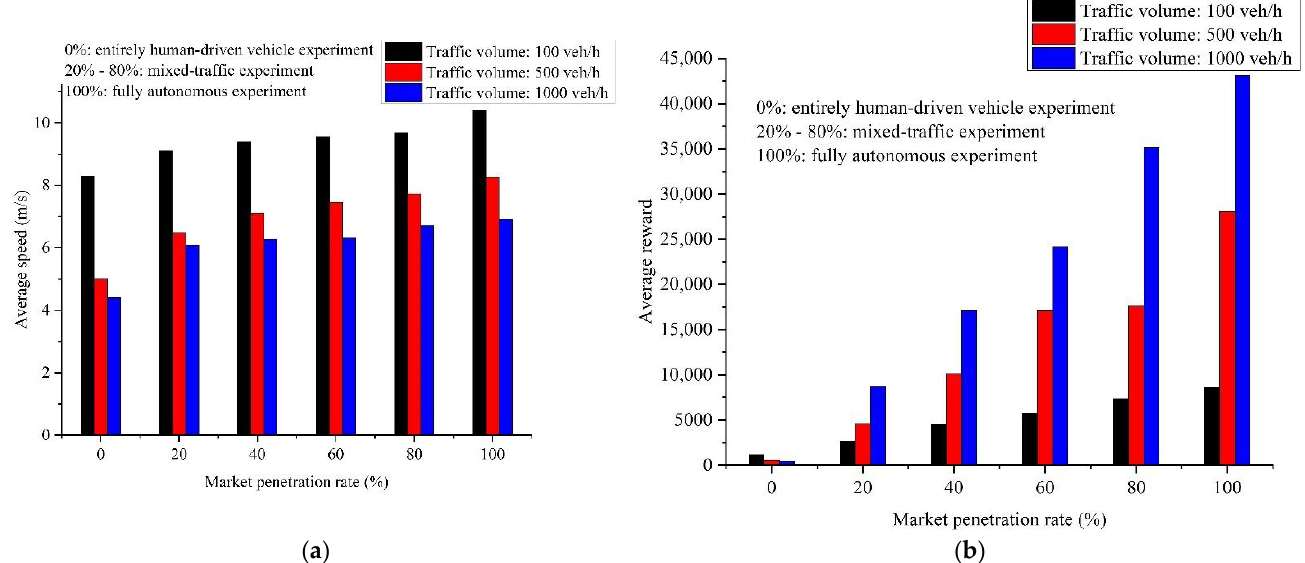
Figure 10. A comparison of the entirely human-driven vehicle experiment with different traffic volumes: ( a ) Average speeds; ( b ) Average rewards.